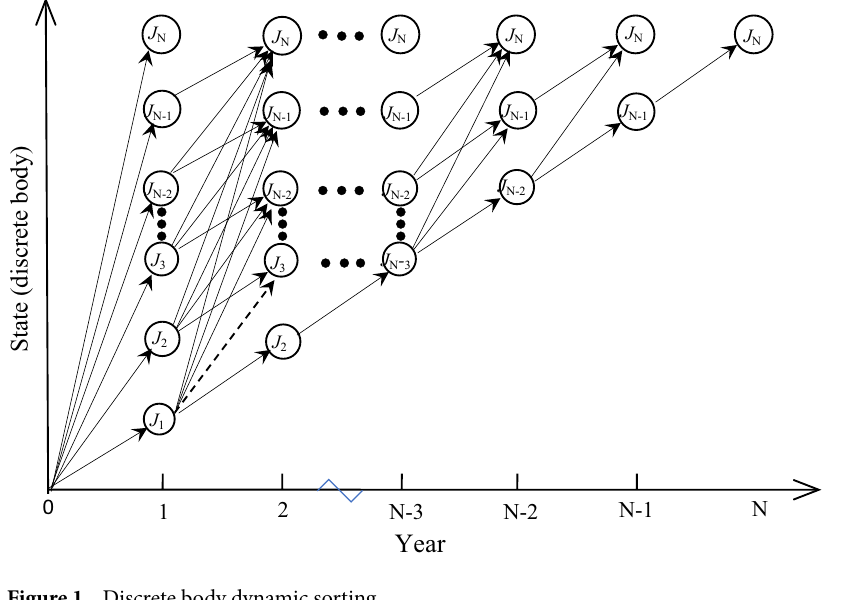
Figure 1. Discrete body dynamic